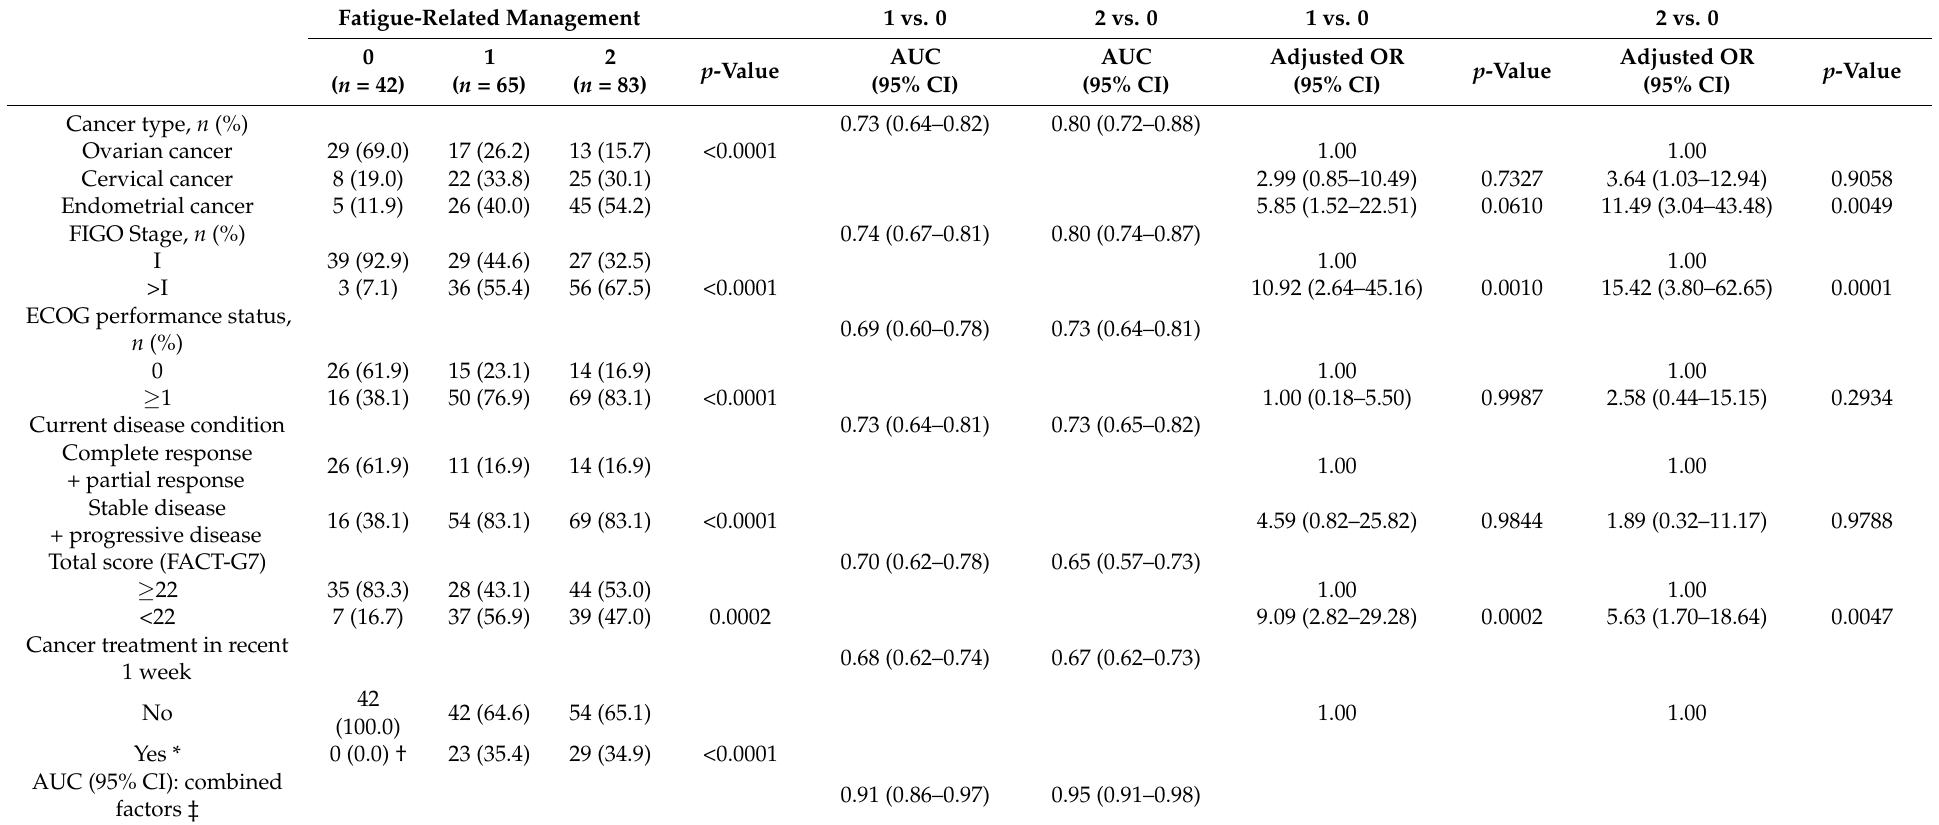
FIGO, International Federation of Gynecology and Obstetrics; ECOG, Eastern Cooperative Oncology Group; FACT-G7, Functional Assessment of Cancer Therapy–General–7 Item Version; AUC, area under the receiver operating characteristic curve; CI, confidence interval; OR, odds ratio. The adjusted OR with 95% CI was calculated using a multiple multinomial logistic regression model. * Cell contains 0 by trend analysis (as a continuous variable per category). † Cells containing 0, not calculated. ‡ The performance of the binary logistic regression model was assessed using the